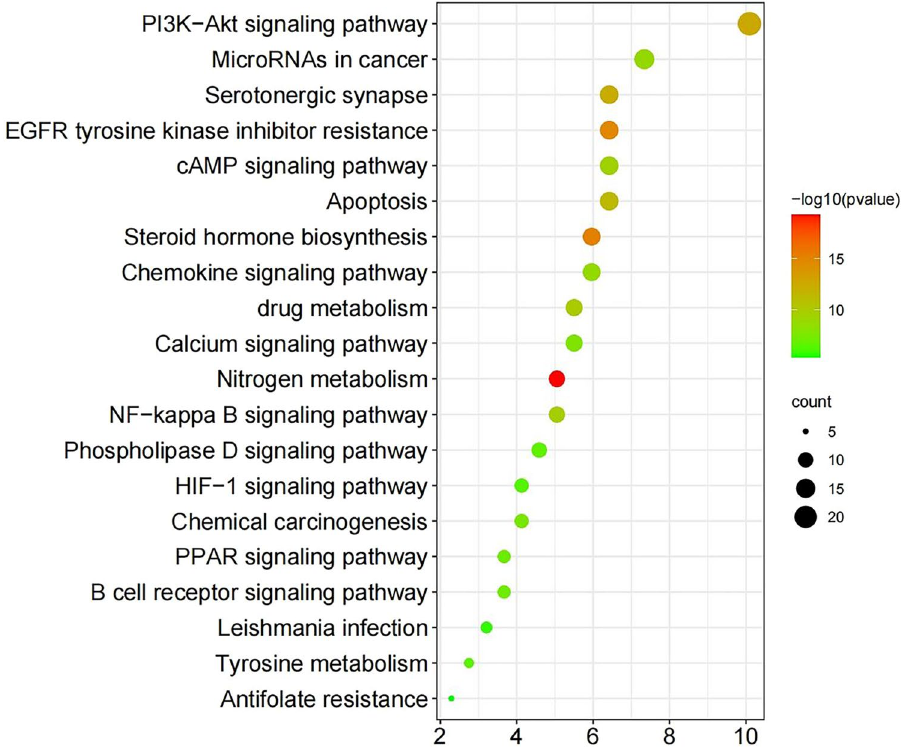
Figure 5. KEGG pathway analysis. The X -axis refers to the number of enriched targets in a pathway as a percentage of total targets, and the Y -axis refers to the enrichment pathways. The size of the points depends on the number of targets enriched in a pathway. The colour of the points depends on − log10(p value). The darker the colour is, the more significant the